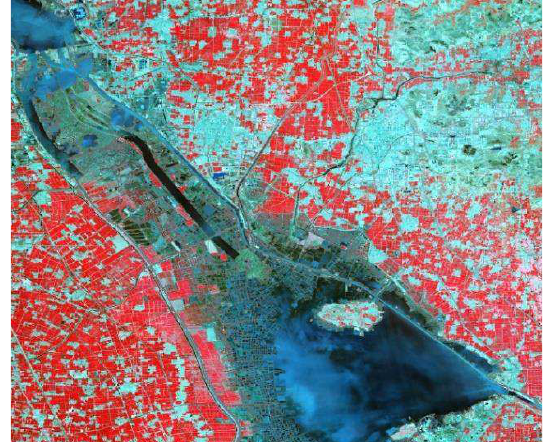
Figure 1. False-color composite of the AHSI surface reflectance image of Nansi Lake